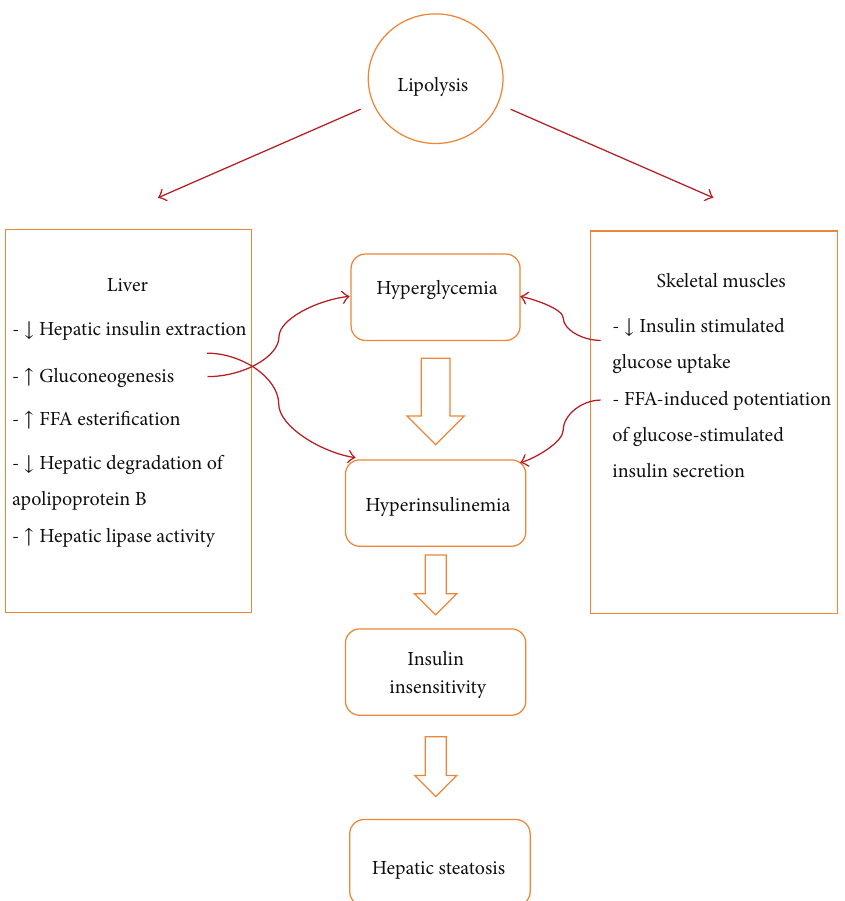
Figure 1: Some of the pathophysiologic mechanisms involved in the pathogenesis of fatty